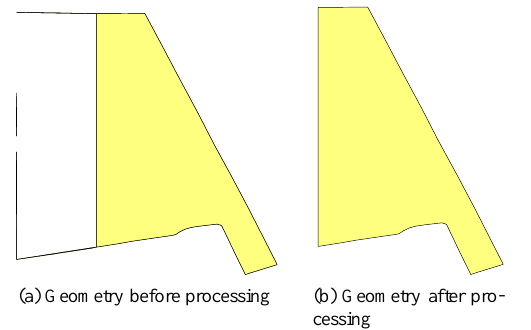
Figure 5: Spike removal of data before insertion into the database. Figure 5 is an example of spike removal, one type of process- ing used in Inteligeo. This procedure relies on buffer operations and can be performed safely only on valid geometries. Figure 5 shows typical artifacts remaining from operations such as the in-